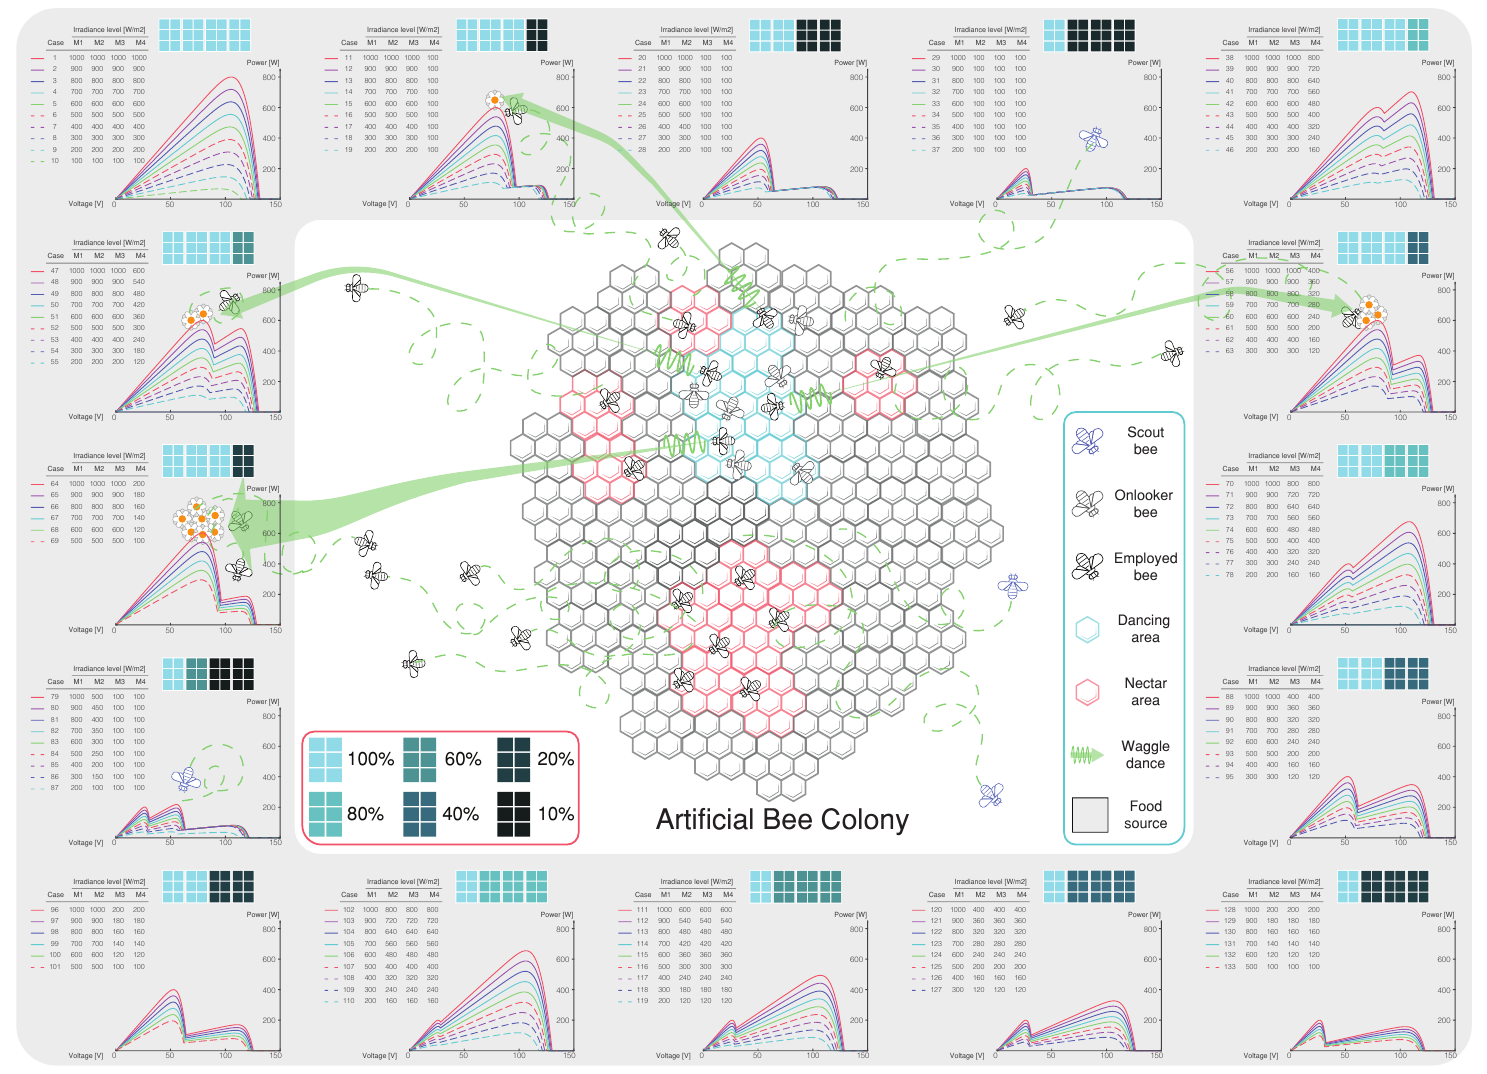
Figure 2. P–V characteristics of four PV modules KC200GT connected in series under uniform and nonuniform irradiance